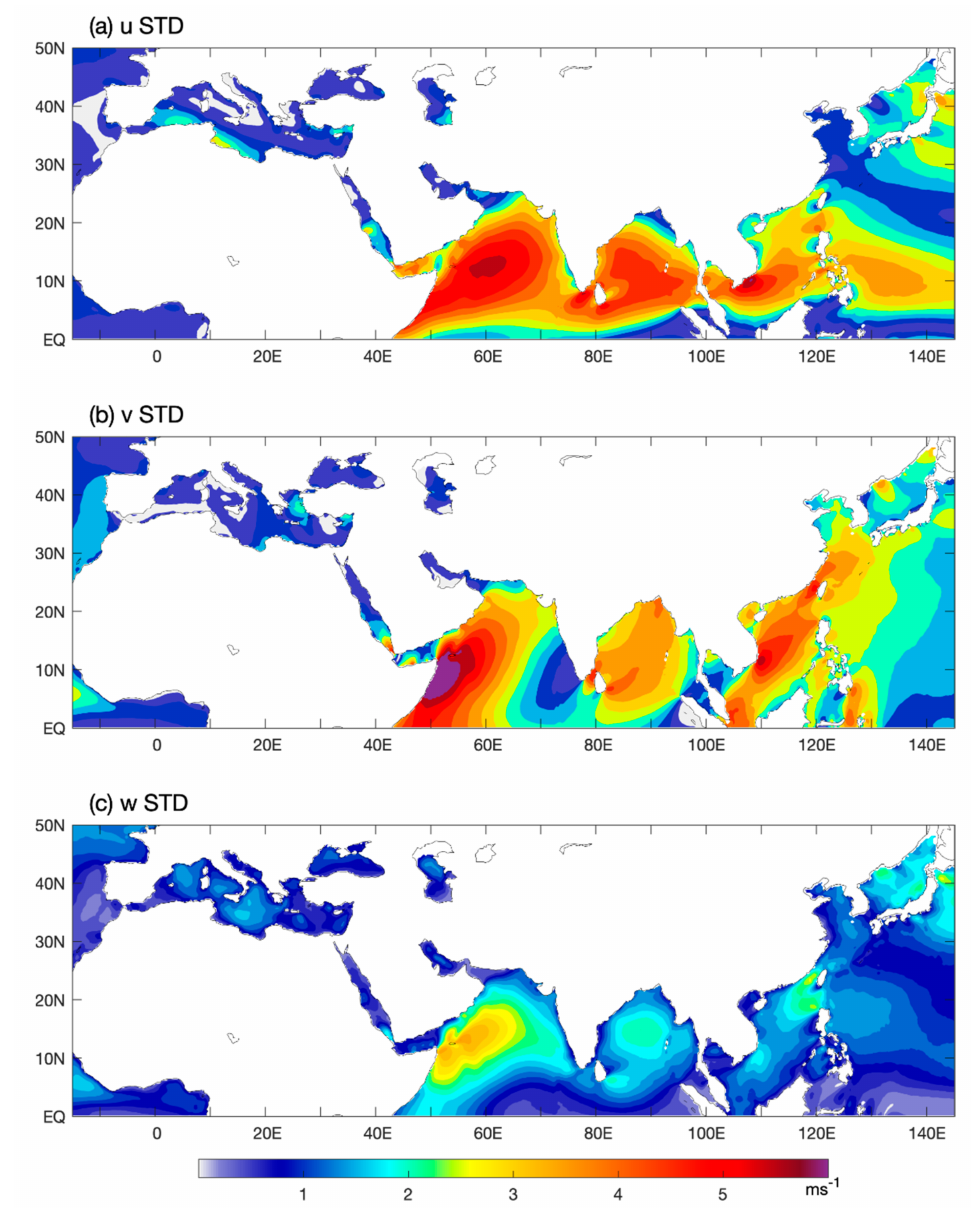
Figure 7. Standard deviation (STD) of seasonal variability of ( a ) zonal wind ( u ), ( b ) meridional wind ( v ), and ( c ) wind speed ( w